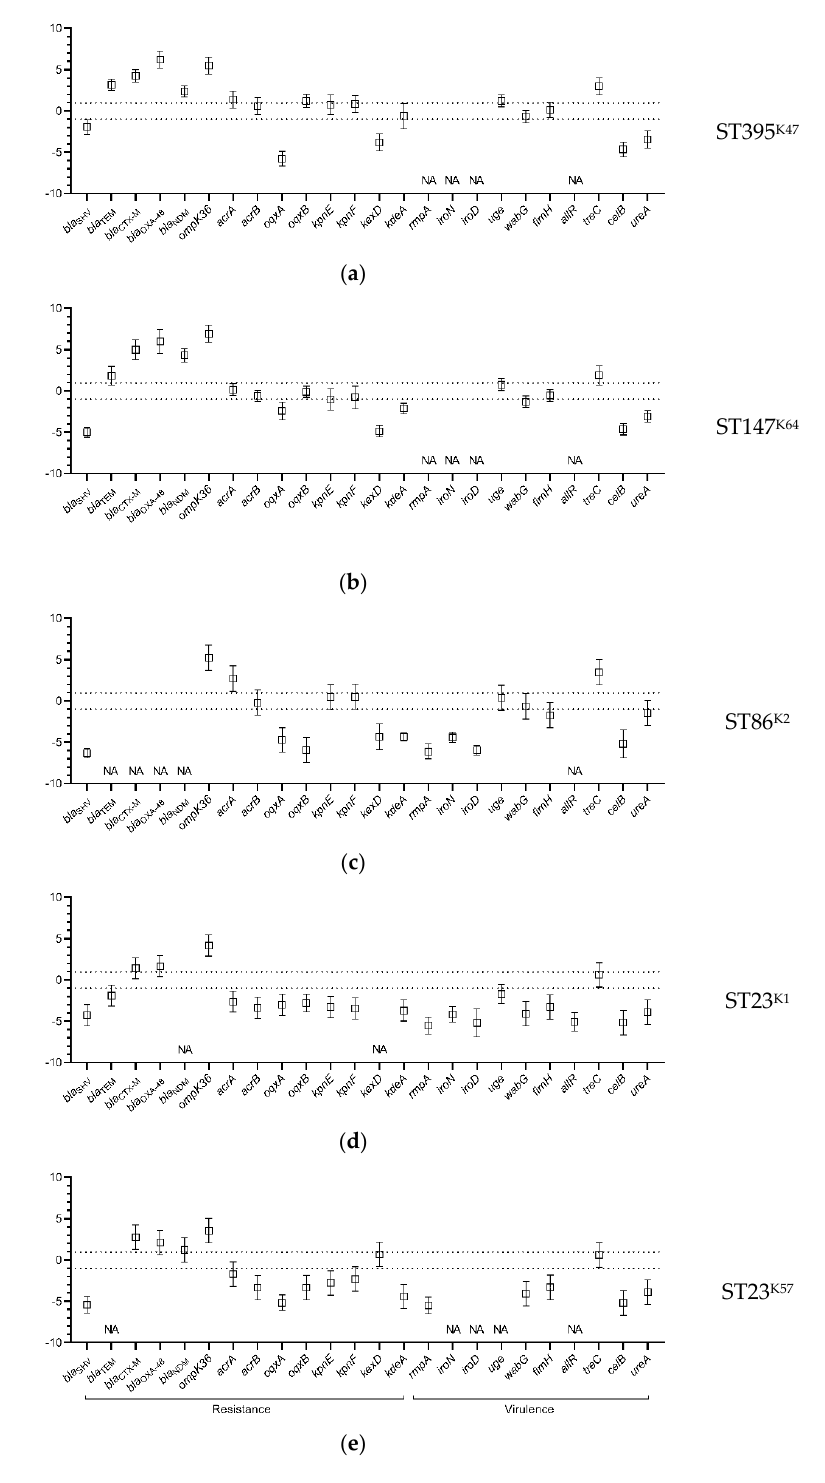
Figure 3. Expression levels of K. pneumoniae antimicrobial resistance and virulence genes detected in the strains: ( a ) B-185/19; ( b ) B-16K/19; ( c ) B-2523/18; ( d ) B-2580/14; and ( e ) B-1261/19 detected by qPCR compared with rpoD gene as a reference. Expression levels for three replicates along with the standard error of the mean are shown on the plots; the area of no significant differences with the expression of the reference gene (from minus 1 to 1) are circumscribed by dotted lines; NA, not